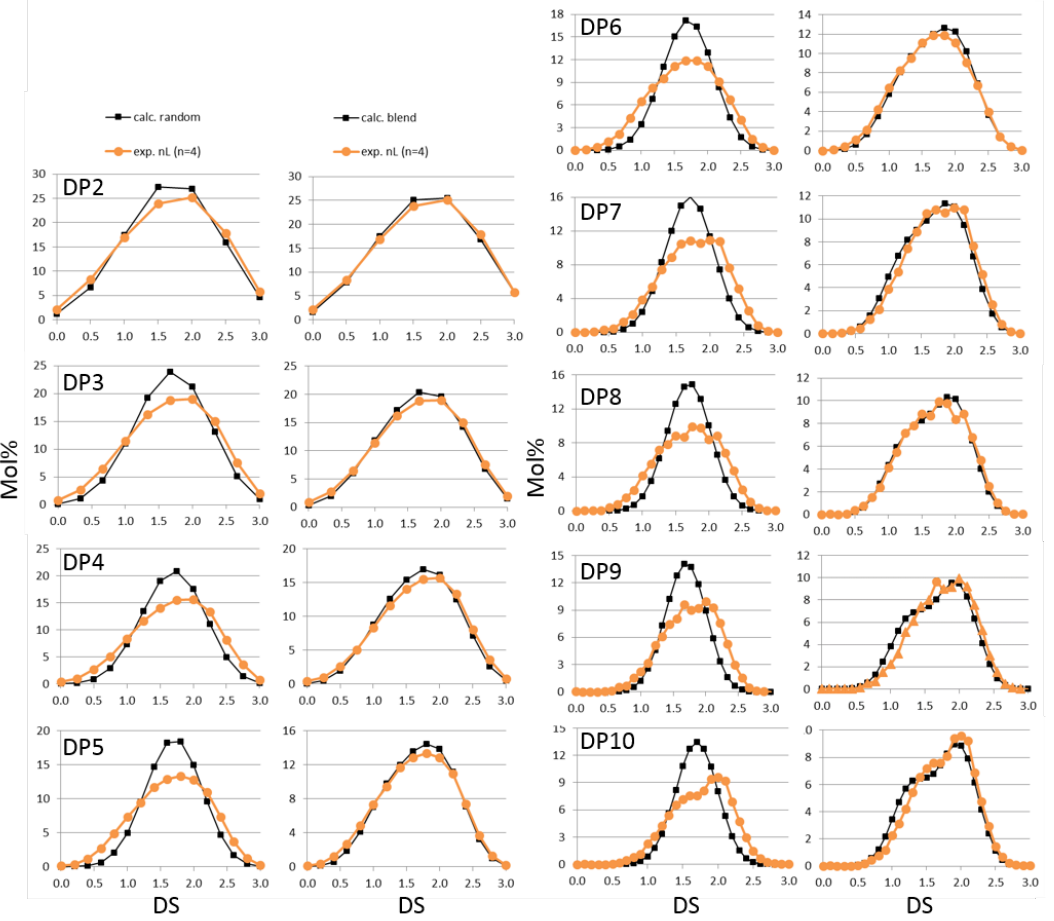
Figure 4. Comparison of the experimentally determined methyl distributions (orange) of COS for DP2-10 with various calculated random profiles (black). Sample: blend of MC 1.29 and MC 1.96 (2:3); DS 1.67. Left (1st and 3rd column): comparison with random methyl profile calculated for the overall monomer composition of the blend; right (2nd and 4th column): comparison with weighted combination of random profiles of MC 1.29 (40%) and MC 1.96 (60%), i.e., theoretical profile for the blend (with random distributions for both MCs).